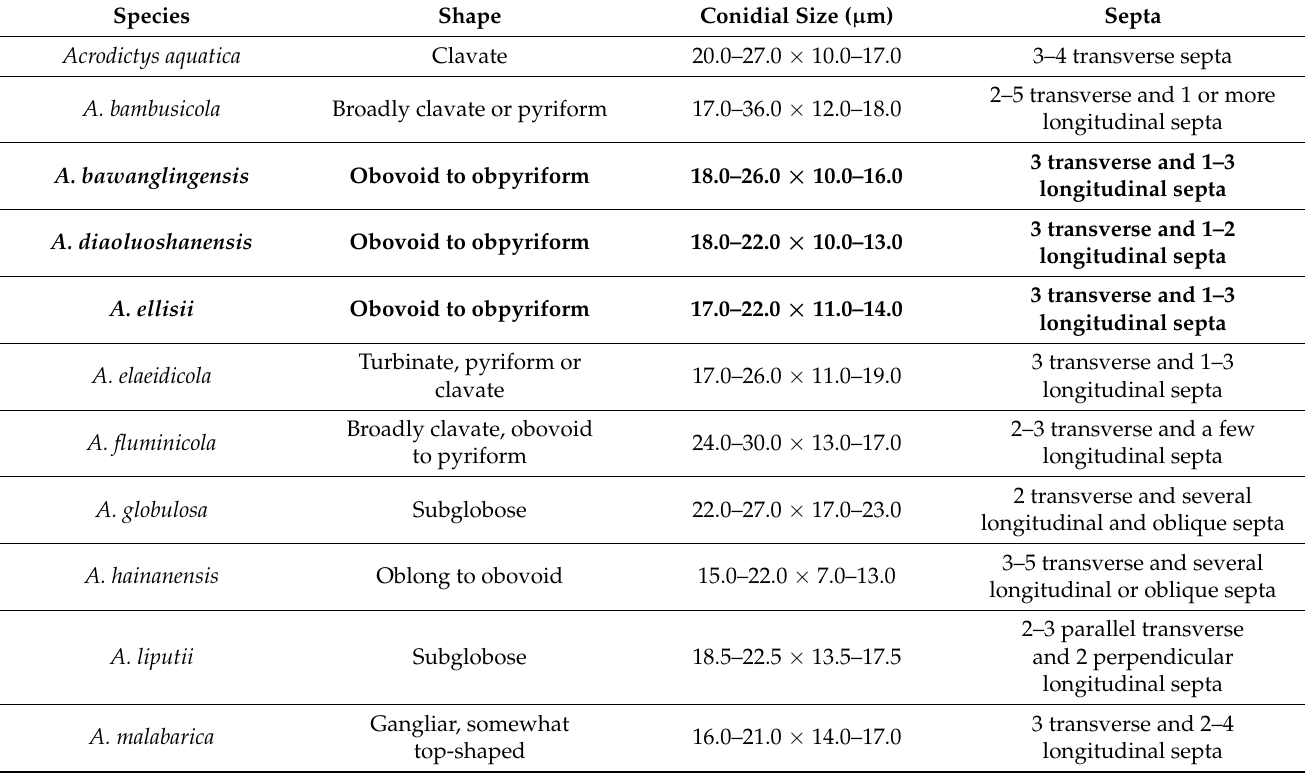
Table 3. Micromorphological comparison of phylogenetically related Acrodictys species. Species